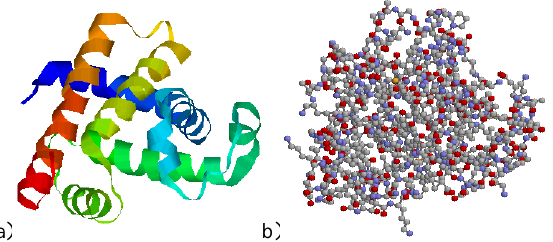
Fig. 2. Spatial structure of the myoglobin (PDB ID: 1MBN): a) secondary structure representation, b) atomic representation of the tertiary structure in the RasMol viewer. 32